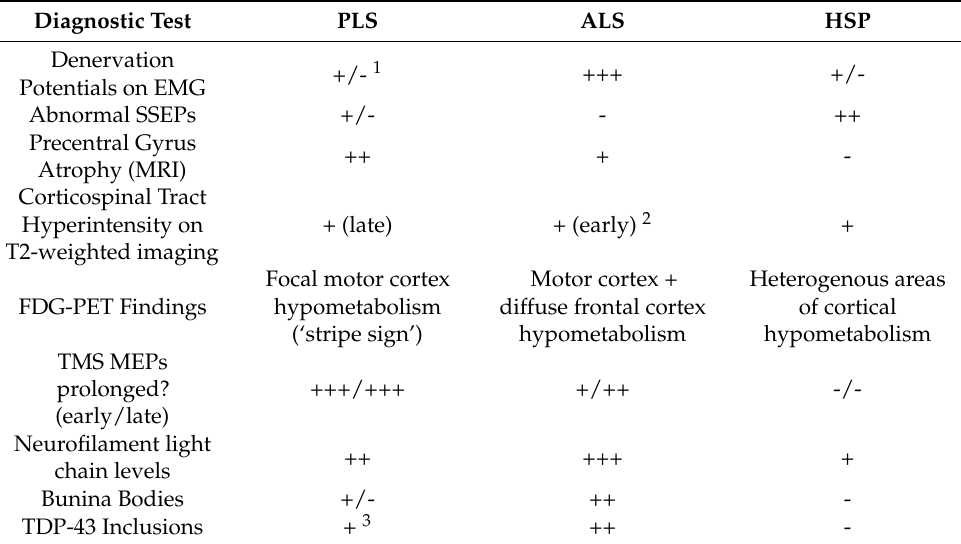
Table 2. Key diagnostic differences between ALS, HSP, and